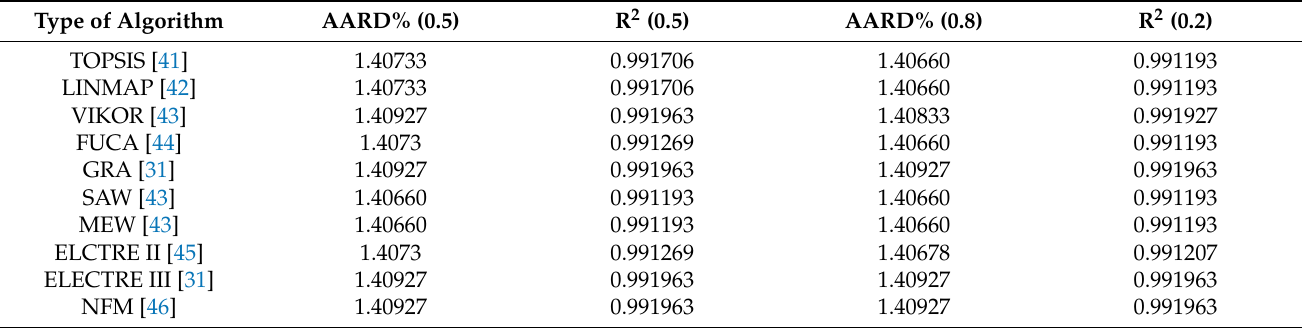
Table 1. Comparison between the results provided by the ten algorithms for choosing the optimal solution available in